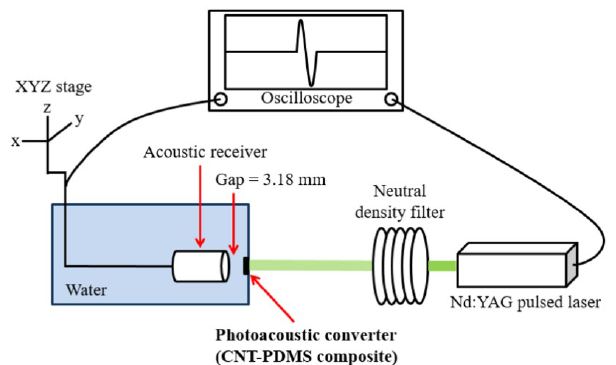
Figure 1. An experimental setup for nanosecond pulsed laser measurement using a combination of a carbon nanotube-polydimethylsiloxane (CNT-PDMS) transmitter and an acoustic receiver. Two acoustic receivers were used alternately for characterization: a wide-aperture piezoelectric receiver (25-mm diameter) for high-sensitivity measurements and a broadband needle hydrophone (20-MHz bandwidth) for pulse width measurements.